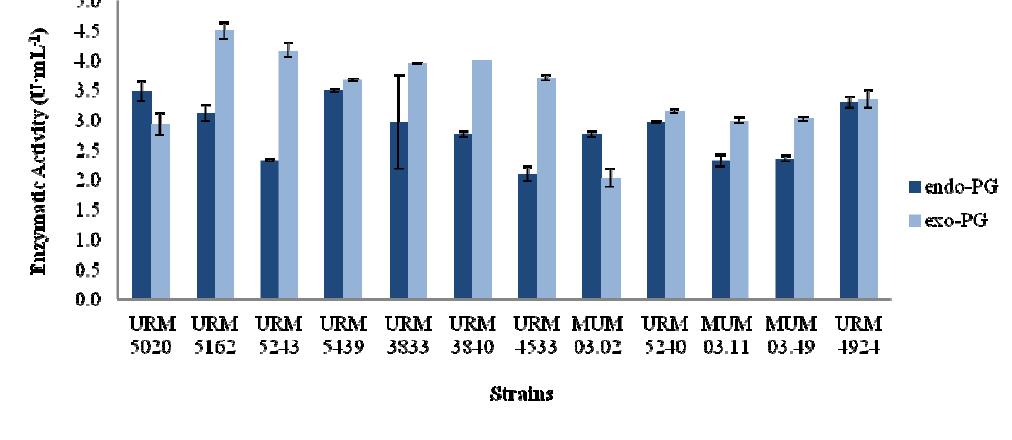
Figure 1. Endo-polygalacturonase and exo-polygalacturonase activities from 12 high producer strains of Aspergillus at 72